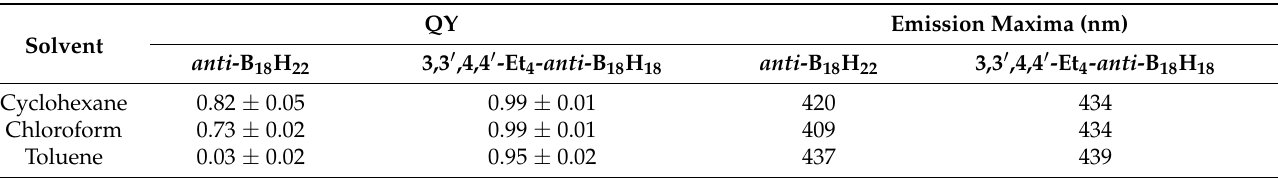
Table 3. QY of borane compounds in different solvents mixed with polystyrene solutions.